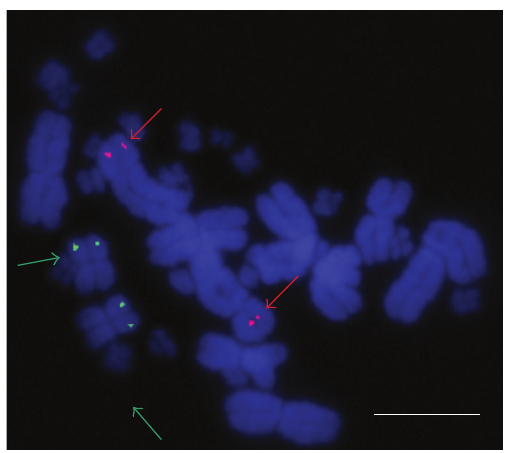
Figure 2: An example of two-color BAC-FISH showing hybridizations of BAC clones containing sex-linked genes from snake and chicken in a metaphase chromosome spread from an Australian bearded dragon (Pogona vitticeps). Red arrows indicate hybridization signals of a BAC clone containing chicken sex-linked gene CHD1 (red signals) onto the short arms of chromosomes 2 in P. vitticeps ; green arrows indicate hybridization signals of a BAC clone containing snake sex- linked gene KLF6 onto the short arms of chromosomes 6 in P. vitticeps , thus showing nonhomology of ZZ/ZW sex chromosomes in reptiles [5]. Scale bar indicates 10 µ